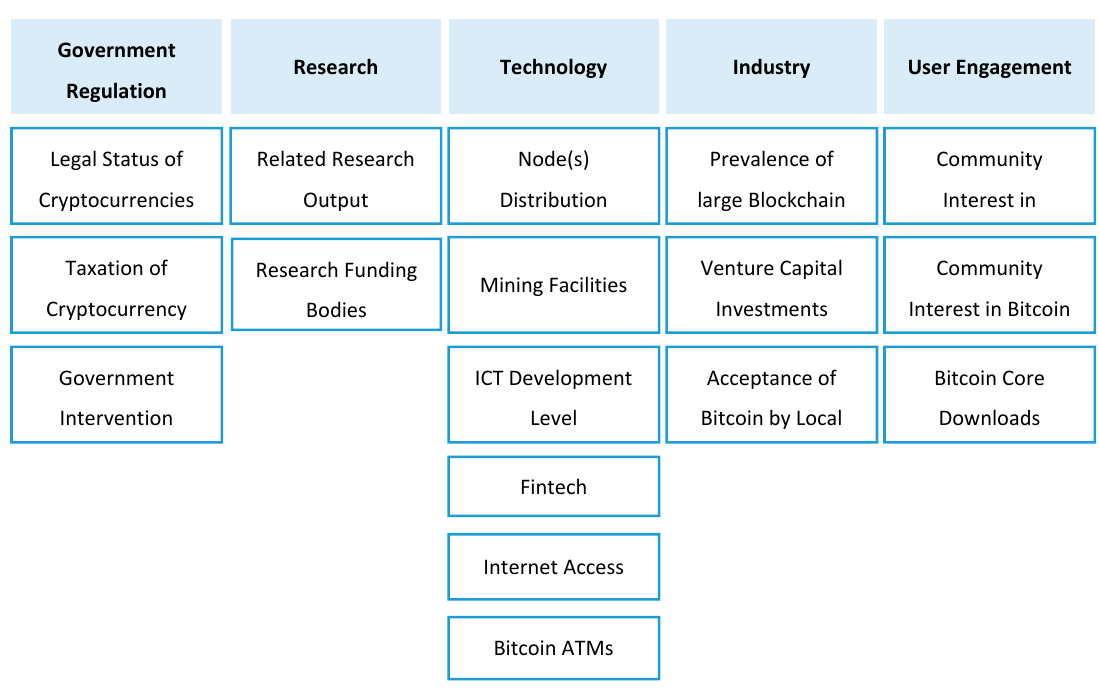
Figure 1. Indicators considered for the proposed Blockchain Readiness